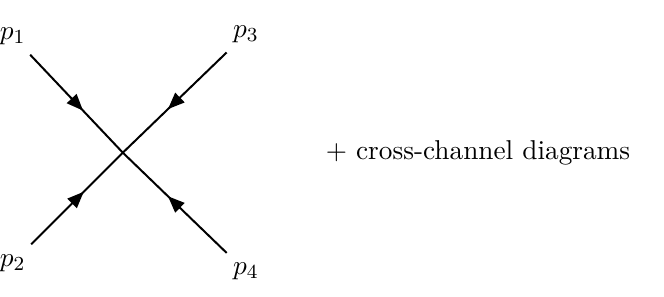
Figure 1 . Tree level diagram’s. Cross-channel corresponds to two other channel of